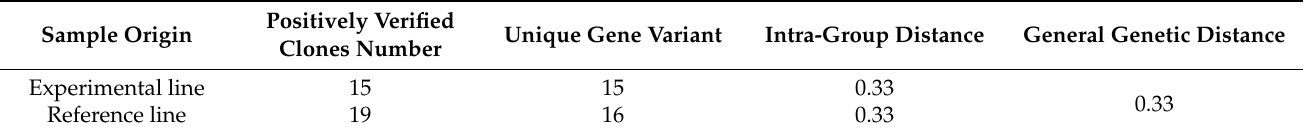
Table 4. Genetic distance values, number of positively verified clones and number of unique sequences within libraries for the nirK